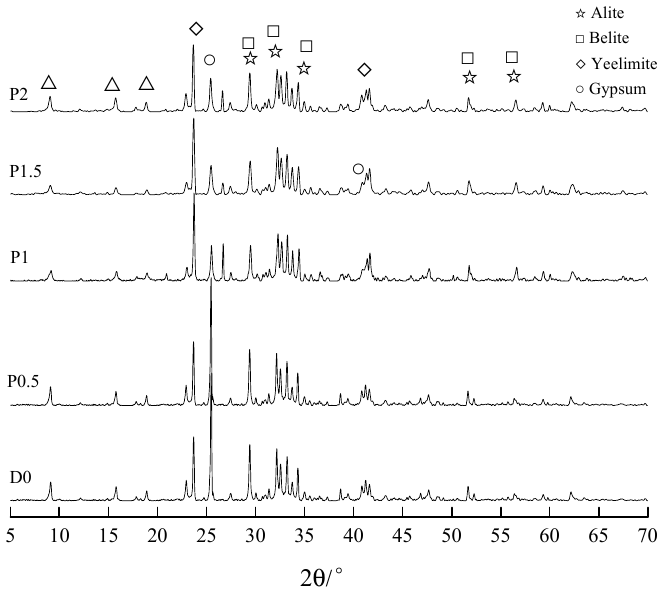
Figure 9. XRD patterns of composite cement at 4 h.